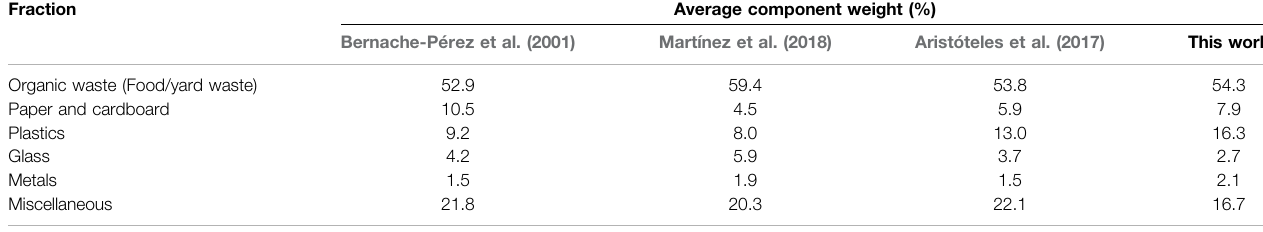
TABLE 3 | GMA MSW composition studies comparison.